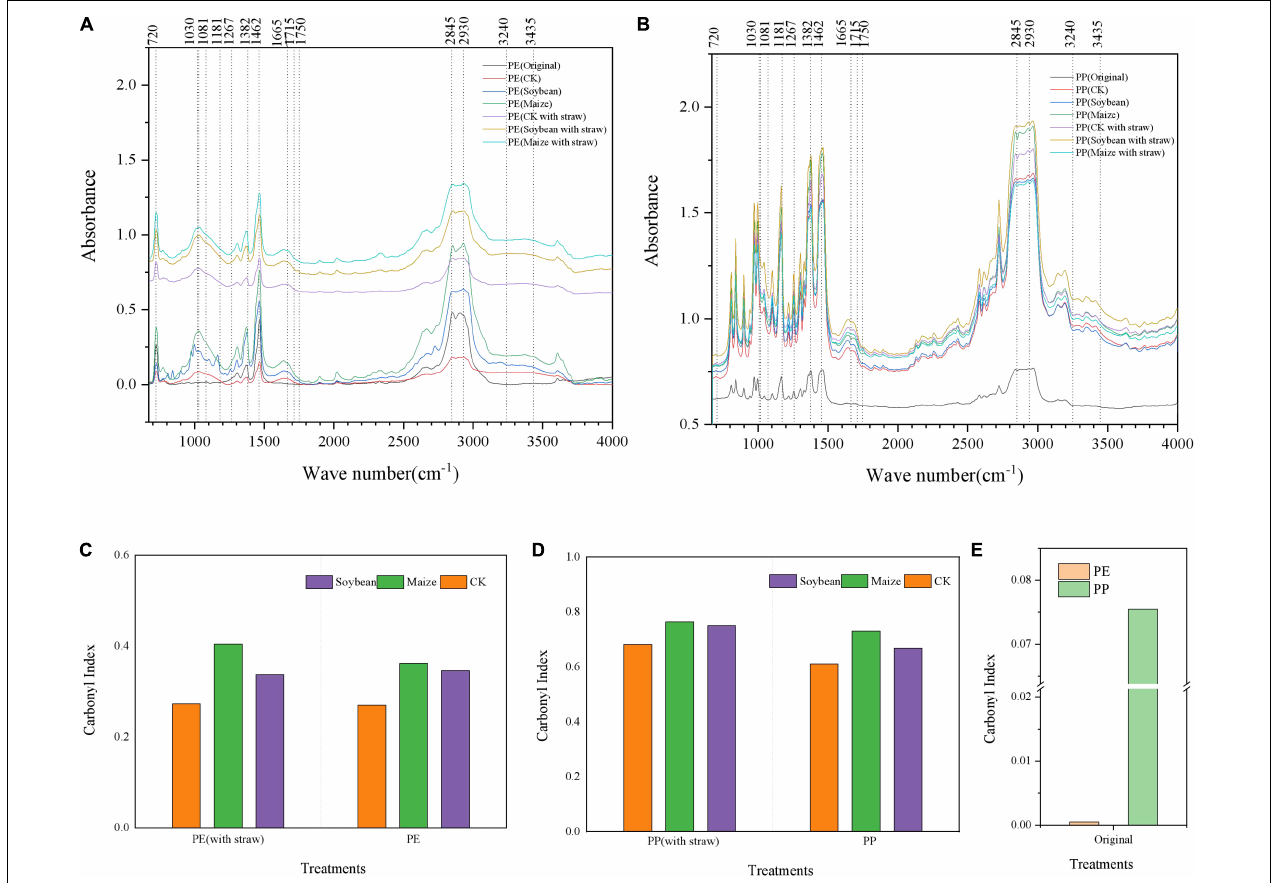
FIGURE 3 | The Fourier infrared spectra and carbonyl index of low-density polyethylene (LDPE) and low-density polypropylene (LDPP) microplastics were different in the treatments of crops growth (soybean and maize, with and within straw addition). (A) LDPE-MP and (B) LDPP-MP. (C) Carbonyl index of LDPE-MP, (D) carbonyl index of LDPP-MP, and (E) carbonyl index of original LDPE-MPS and LDPP-MPS. CK was the control treatment without crop growth, and the original was LDPE-MPS and LDPP-MPs before the experiment. All spectra were the average spectra of the spectra of four random particles and were analyzed by microscopic infrared spectroscopy (Nicolet iN10, Thermo Scientific) using OMNIC software (Thermo